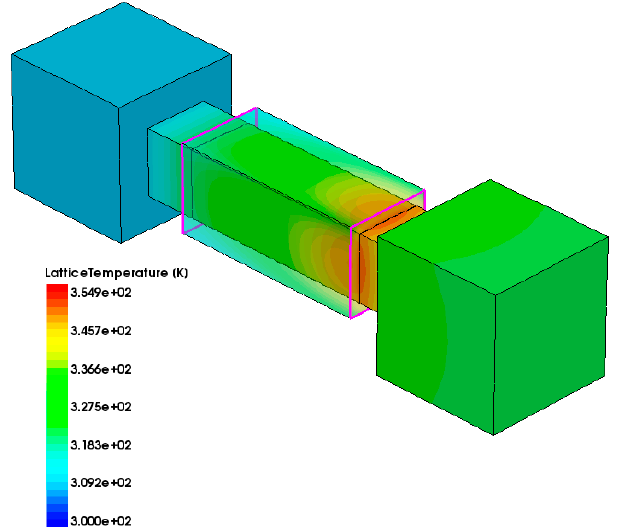
Figure 2. Distribution of lattice temperature at self-heating condition: @ V GS = V DS = 0.7 V.